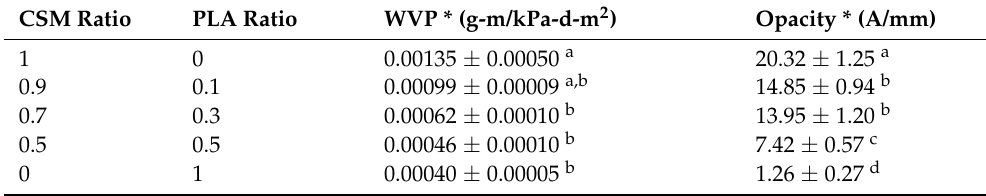
Table 2. Water vapor permeation (WVP) and opacity of bilayer films of CSM and PLA. CSM